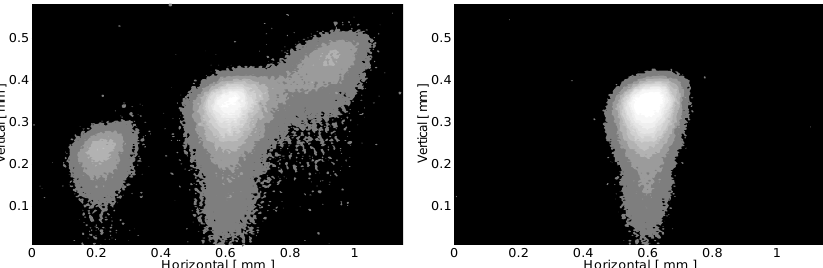
FIG. 14. Synchrotron radiation image of the beam near the (cid:51) n (cid:120) resonance. Left is the situation before the optic is corrected and right is the situation after the optic is corrected. (The plane of the camera is rotated with respect to the plane of the beam.) Also there is a distortion in the light optic in the vertical plane that is responsible for the image’s vertical asymmetry.